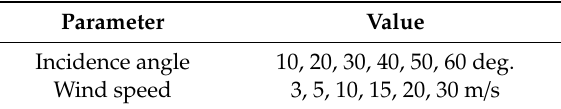
Table 2. Simulation parameters as a preliminary